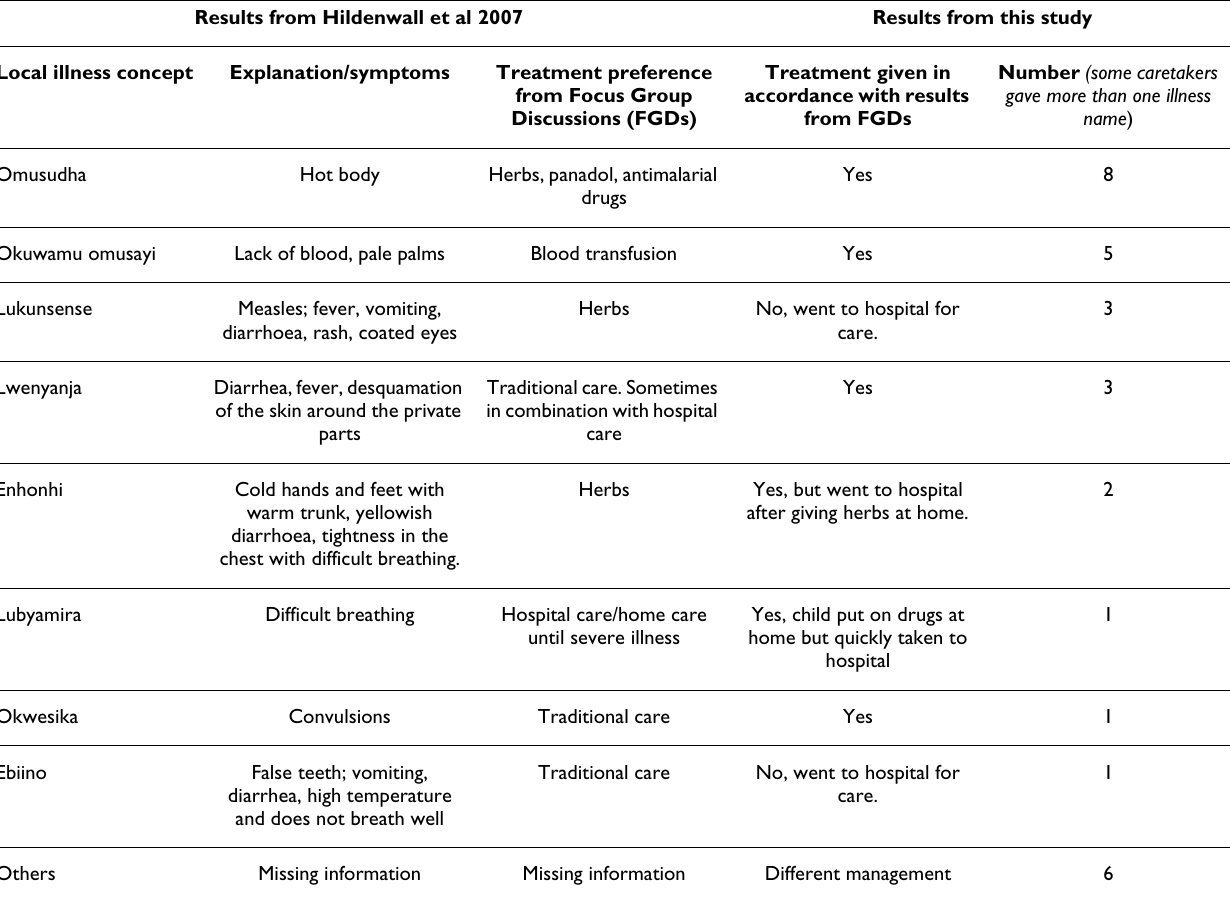
Table 1: Agreement between symptoms and treatments for different illnesses given in Focus Group Discussions with mothers in other study [7] and action reported in in depth interviews Results from Hildenwall et al 2007 Results from this study Local illness concept Explanation/symptoms